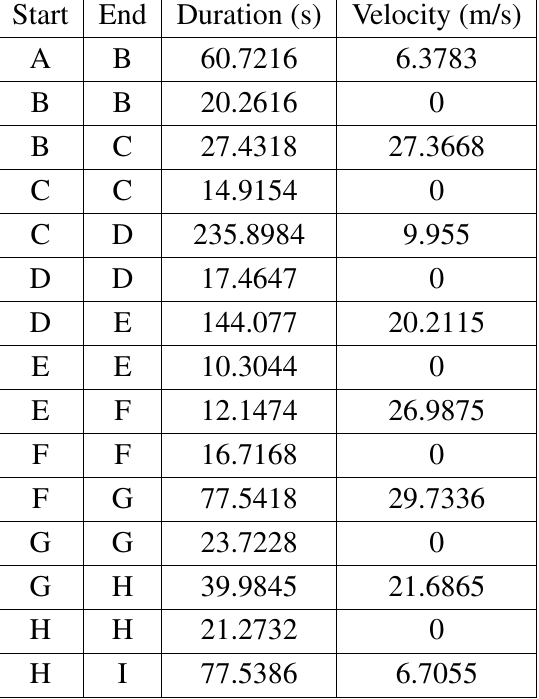
Table 4. The user motion parameters for feasibility analysis in a WiMAX